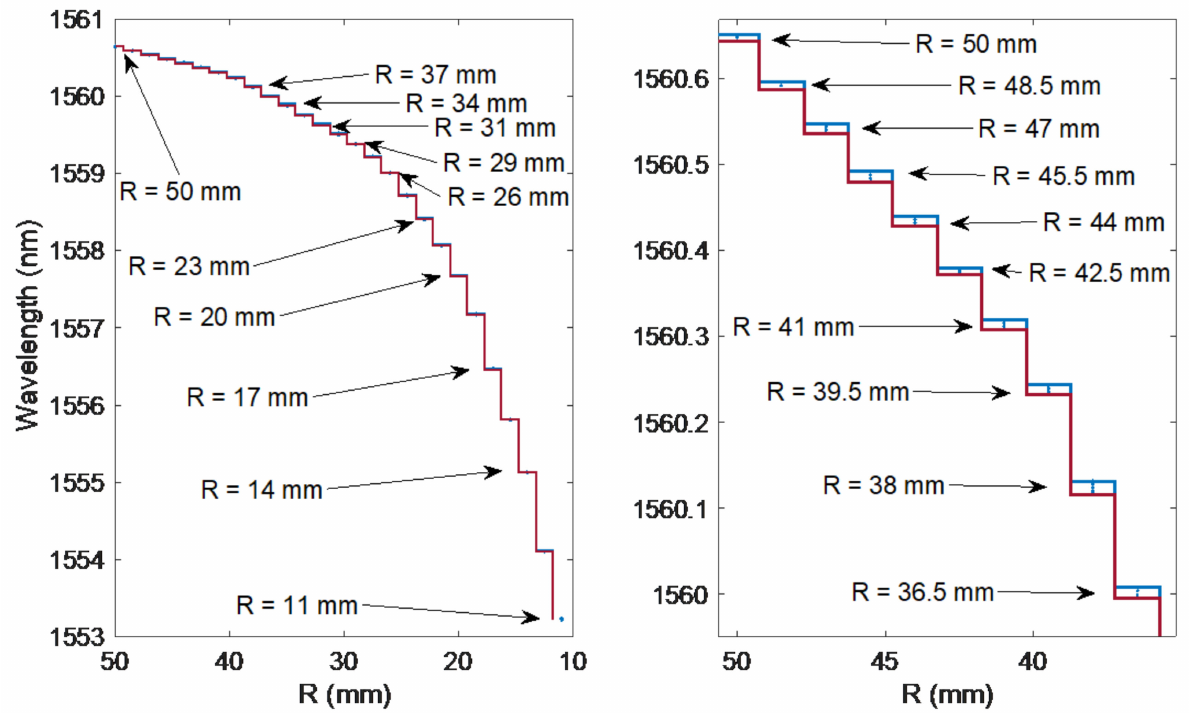
Figure 9. Modification of the mode leakage wavelength under the influence of the change of the bending radius of the optical fibre for 27 bending radii and nine measurements for each radius.